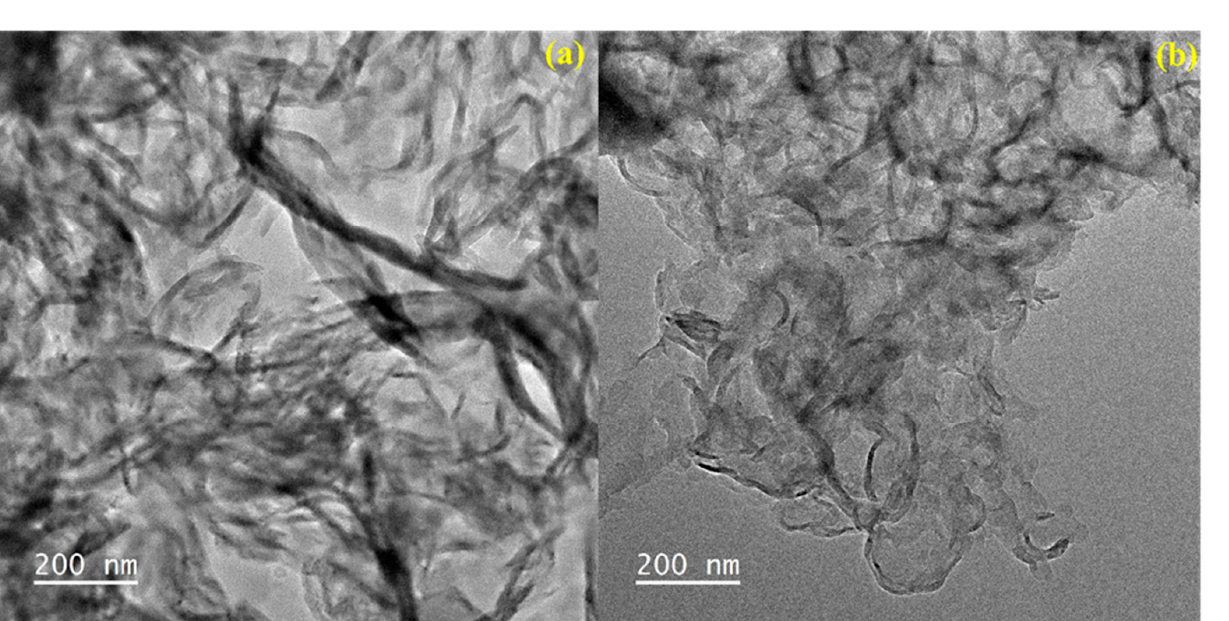
Figure 5. Surface topography studies of ( a ) bulk and ( b ) doped gCN nanosheets.